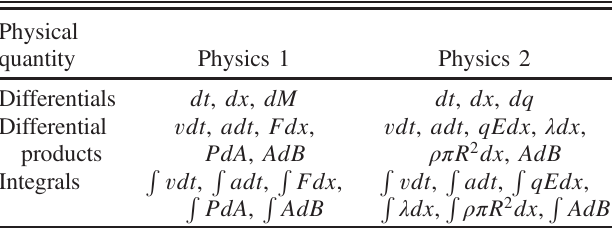
TABLE I. Categories and physical contexts of assessment items for each population. Each quantity in the Physics 1 and 2 columns corresponds to two assessment items: a physical interpretation question and an explicit units question, both employing identical physical scenarios. For examples of indi- vidual items, see Appendixes A and